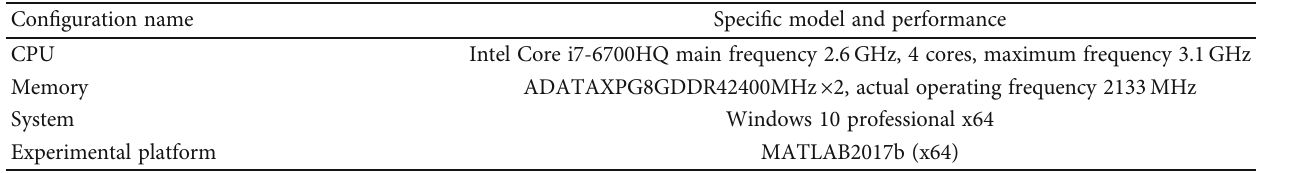
Table 2: PC con fi guration required for experiment.